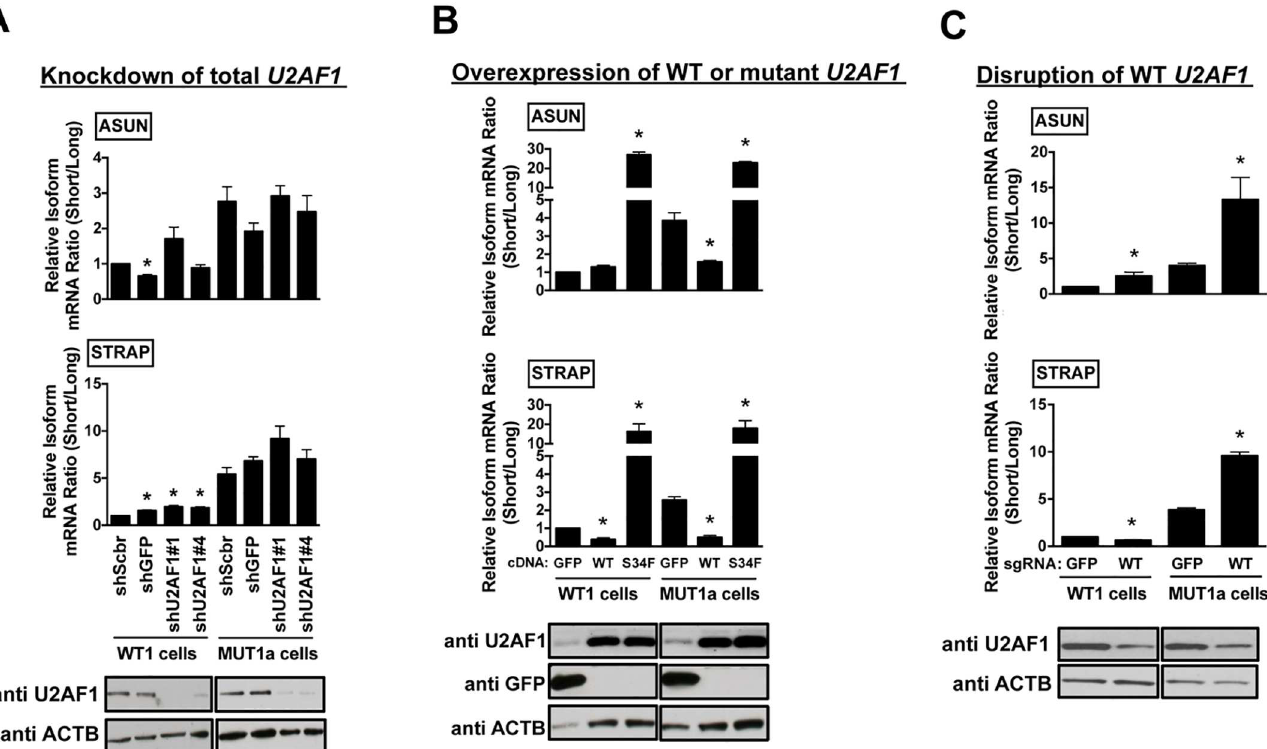
Fig 3. The ratio of S34F:WT U2AF1 gene products controls S34F-associated splicing in isogenic HBEC3kt cell lines. (A) . Reductionof both mutant and wild-type U2AF1 RNA and protein does not affect S34F-associated splicing. WT1 and MUT1a cells were transduced with shRNAs against U2AF1 (shU2AF1#1 and #4) or two control shRNAs (shScbr, a scrambled shRNA; shGFP, an shRNA against GFP ). Total RNA and protein were harvested 4 days later. The frequencies of incorporation of cassette exon sequencesin ASUN and STRAP mRNAs (top and middle panels) were determinedby the relative short/long isoform ratios by RT-qPCR, as representedin Fig 2C. Immunoblotsfor U2AF1 and ACTB in total cell lysates are shown in the bottom panel. Asterisks represent statistical significant changes as compared to shScbr-transduced conditionin each cell line. Error bars represent s.e.m (n = 3). (B) . Overexpression of wild-typeor mutant U2AF1 to change S34F:WT ratios alters S34F-sensitive splicing. WT1 and MUT1a cells were transduced with expressionvectors encoding GFP , wild-type(WT) or mutant (S34F) U2AF1 for 3 days before harvesting cells to quantify the level of splicing changes and proteins as in panel A. Asterisks represent statistical significant changes as compared to GFP- transduced conditionin each cell line. Error bars represent s.e.m (n = 3). (C) . Disruptionof WT U2AF1 by gene editing to increase S34F:WT ratios enhancesS34F-sensitive splicing. WT1 and MUT1a cells were transduced with Cas9 and either sgRNA-GFP or sgRNA-WT. Total RNA and protein were harvested 6 days later for assays as in panel A . Asterisks represent statistical significant changes as compared to Cas9 and sgRNA-GFP- transduced conditionin each cell line. Error bars represent s.e.m. (n = 3).